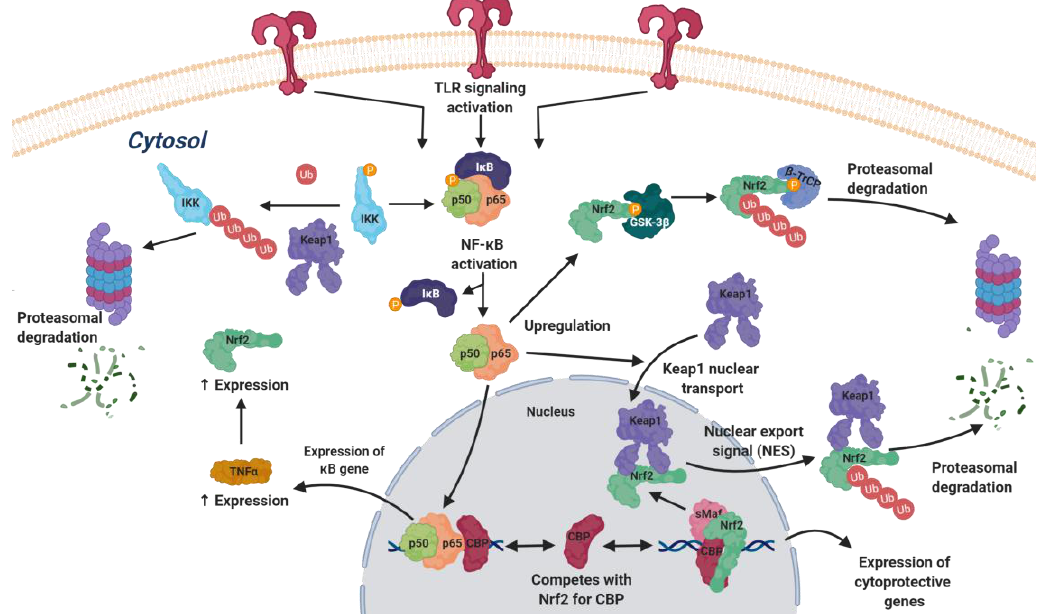
Figure 5. Crosstalk between the nuclear factor-κB (NF-κB) and NRF2 pathways. Upon TLR activation, NF-κB is liberated from its natural repressor, IκB, by phosphorylation promoted by the IKK (IκB kinase) complex. Liberated NF-κB dimer rapidly translocates into the nucleus where it binds to CREB binding protein (CBP), competing with NRF2, and it initiates the expression of proinflammatory genes including tumor necrosis factor-α (TNF-α) citokine. NF-κB drives a negative regulation over NRF2 through its monomer p65 by different pathways. p65 promotes the nuclear importation of KEAP1, where it binds to NRF2, concluding the expression of phase II-related genes. Then, the KEAP1–NRF2 complex is exported to the cytosol and coupled to the Cul3 ubiquitin ligase that induces the proteasomal degradation of NRF2. Additionally, GSK-3β directly phosphorylates NRF2, coding its degradation though interaction with β-TrCP. β-TrCP is also able to induce the degradation of IκB (inhibitor of nuclear factor kappa B), increasing the activity of NF-κB and thus limiting NRF2 activation. On the other hand, KEAP1 stabilizes IκB by inducing the degradation of IKK via proteasomal degradation. Thus, it helps to close the crosstalk between NF-κB and NRF2, creating a fine-tuned loop between inflammation and the antioxidant response. 4.3. Proteostasis The misfolding of specific proteins and their subsequent aggregation in a toxic form is the most common feature of NDDs. These aberrant proteins arise from cell stress, mutations, or protein production mistakes [50]. The proteostatic system regulates the synthesis, proper folding, degradation, and clearance of proteins; however, during aging, the accumulation of misfolded proteins collapses the proteostatic system and increases the amount of ubiquitinated inclusion bodies (IBs) [51]. Depending on the disease, different protein aggregates are found such as α-synuclein (α-syn) in PD, β-amyloid (Aβ) plaques and hyper-phosphorylated tau neurofibrillary tangles (NFTs) in AD, huntingtin (Htt) in HD, superoxide dismutase 1 (SOD1), and TAR DNA binding protein 43 (TDP-43) in ALS and scrapie prion protein (PrP Sc ) in spongiform encephalopathies [52]. Strong links have been found between the formation of misfolded protein deposits and adaptive immunity [53]. An interesting crosstalk exists between NRF2 and the protein degradation pathways [54]. The NRF2-mediated transcription of the components of these systems [23,55] enhances the degradation of misfolded proteins, while on the other hand, NRF2 is downregulated by its proteasomal degradation and also via autophagy [54]. Several in vitro and in vivo models have proved the protective role of NRF2-mediated pharmacological activation of protein clearance,